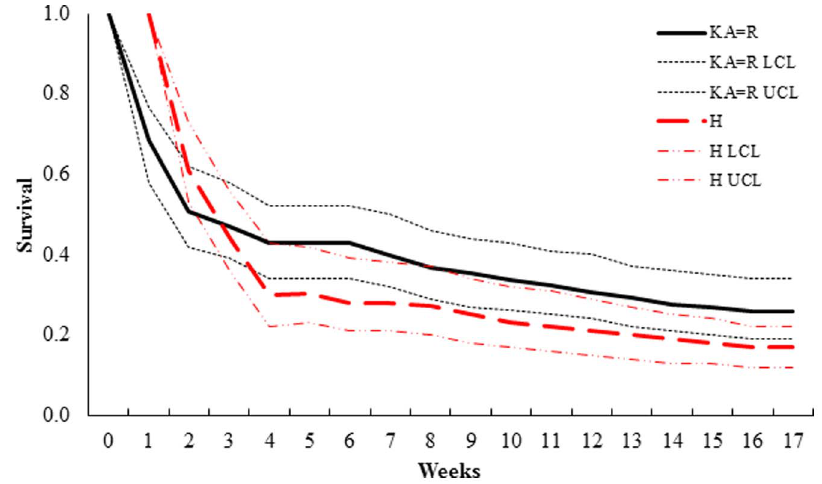
Figure 4. Candidate models of 120-day survival of for mule deer ( Odocoileushemionus ) neonates in California, USA. Survival estimates up to 120 days from top-ranked model (KA=R, H) of mule deer ( Odocoileus hemionus ) neonates ( n =61), California, USA, 2005–2007. The top-ranked model indicated similar survival between known-age (KA) neonates and those aged using the Robinette (R) hoof-growth equation, which differed from neonates aged using the Haskell (H) hoof-growth equation. Equations were obtained from Haskell [17] and Robinette [21].